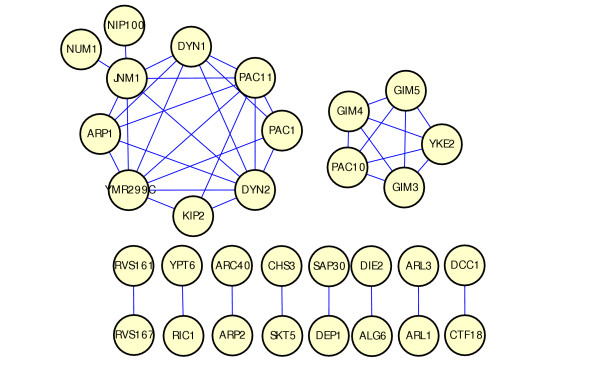
GIMF Type 1 network. The network is created by applying Rule 1 to the motif member lists of all query genes. The network contains 31 nodes and 42 edges, where the nodes are query genes and an edge between node i and node j indicates that i and j are each other's motif members.